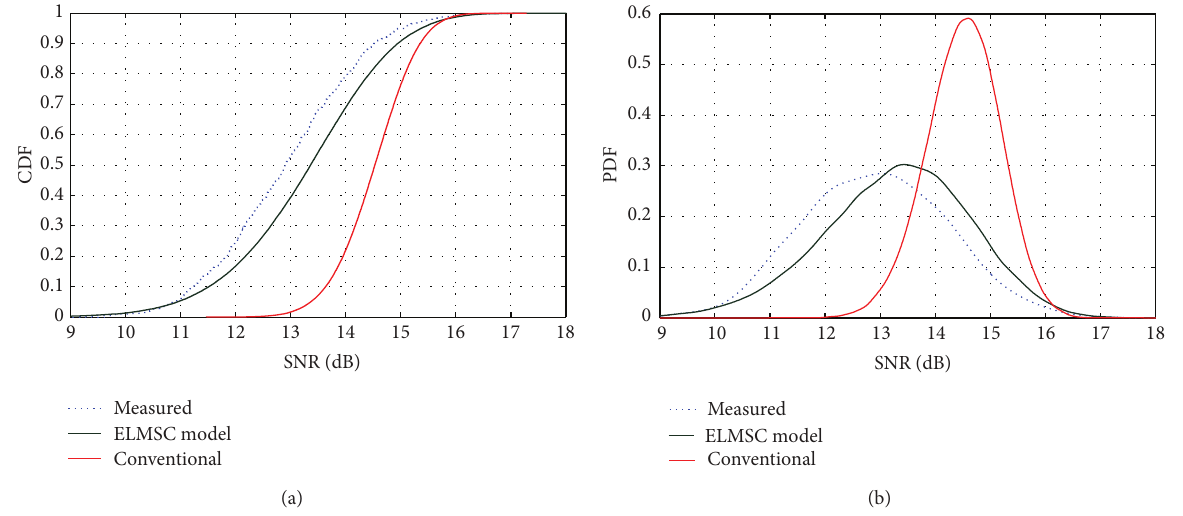
Figure 14: Comparison of channel models with the measured SNR: (a) CDF and (b) PDF.